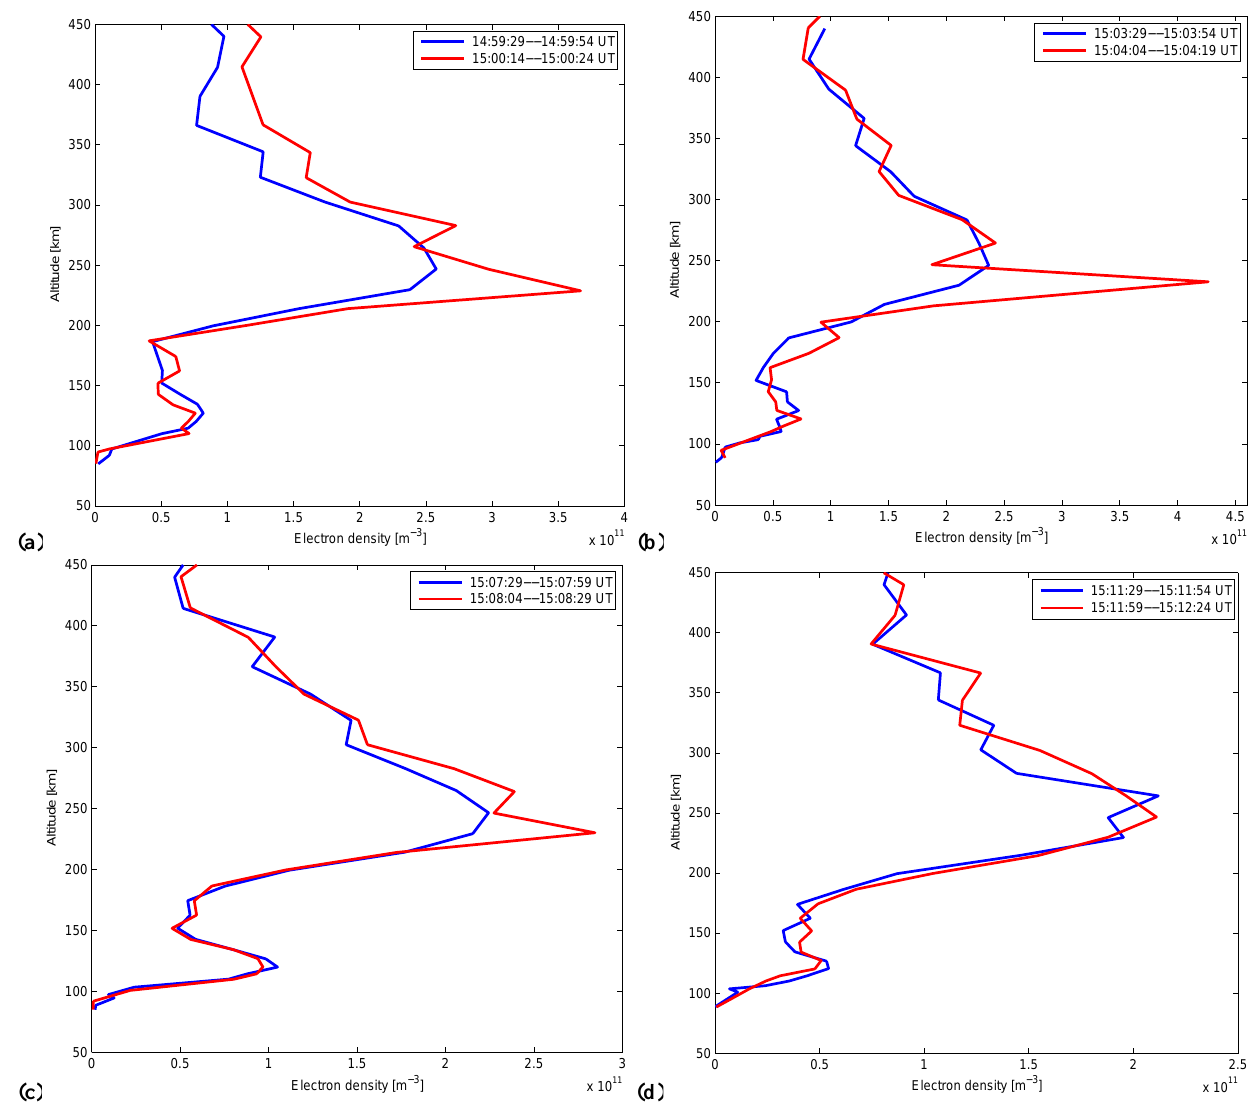
Fig. 10d Fig. 10. Electron density profiles N e (h) from heater-on (red line) and preceding heater-off (blue line) periods obtained from UHF radar measurements on 13 October 2006: (a) the first HF-cycle; (b) the second HF-cycle; (c) the third HF-cycle; (d) the fourth